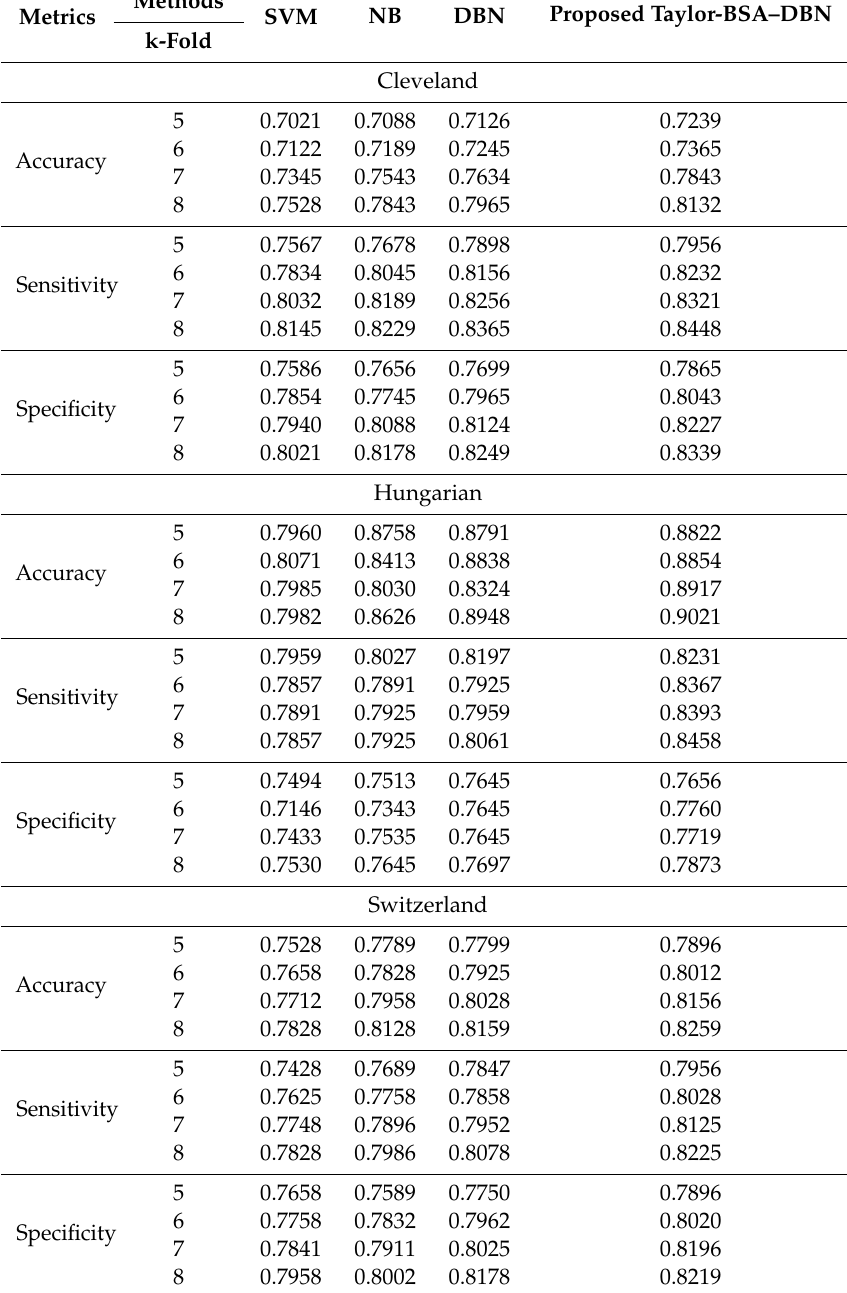
Table 9. Analysis based on